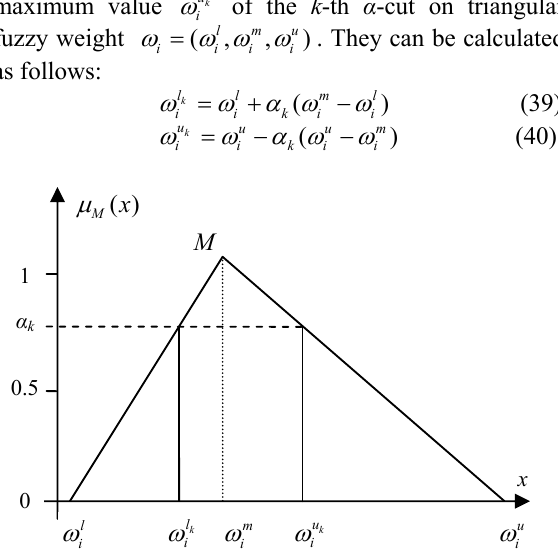
Fig. 9. Minimum and maximum value of the k th α -cut on triangular fuzzy